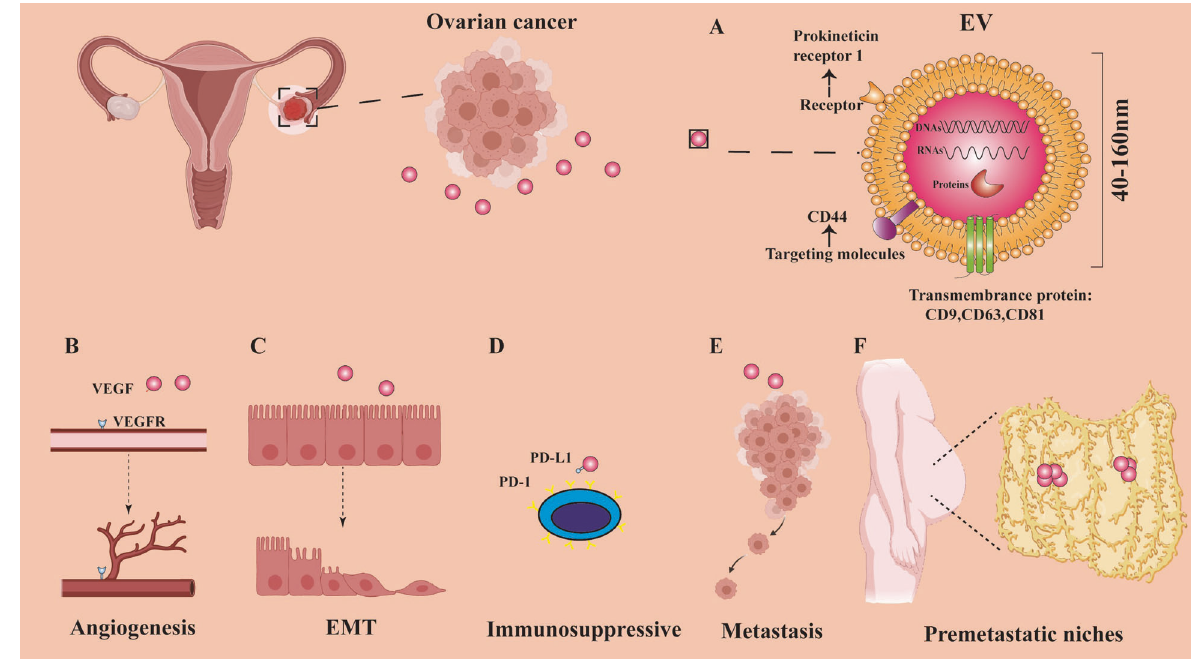
Fig. 2 The role of EVs in OC metastasis. OC-derived EVs promote OC metastasis by promoting angiogenesis, affecting the EMT process, producing immunosuppression, directly stimulating OC cells, and participating in the construction of premetastatic niches. A It shows the general structure, size, content, and markers of EVs [22, 24]. B The VEGF carried by EVs binds to the VEGFR of vascular endothelial cells to promote angiogenesis [79]. C EVs promote the process of EMT [84]. D PD-L1 is expressed on the surface of EVs, which inhibits the activation of immune cells [120]. E EVs directly stimulate OC cells, causing them to metastasize [25]. F EVs are involved in the construction of the niche before OC peritoneal metastasis